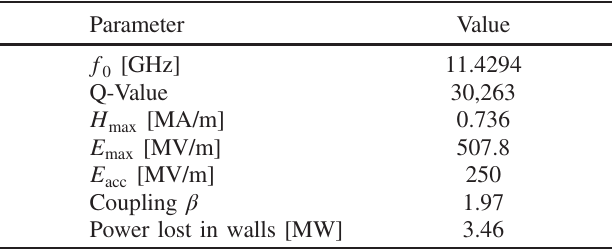
TABLE II. Measured parameters of full Cryo-Cu-SLAC-#2 shown in Fig. 1. Fields are normalized to E the middle cell at 45 K.